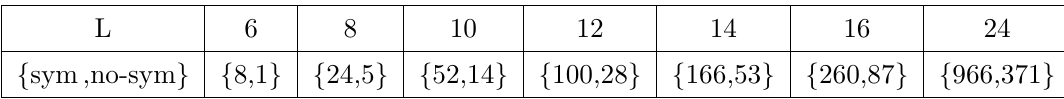
2 ; 4 ; 2 . We classify f g